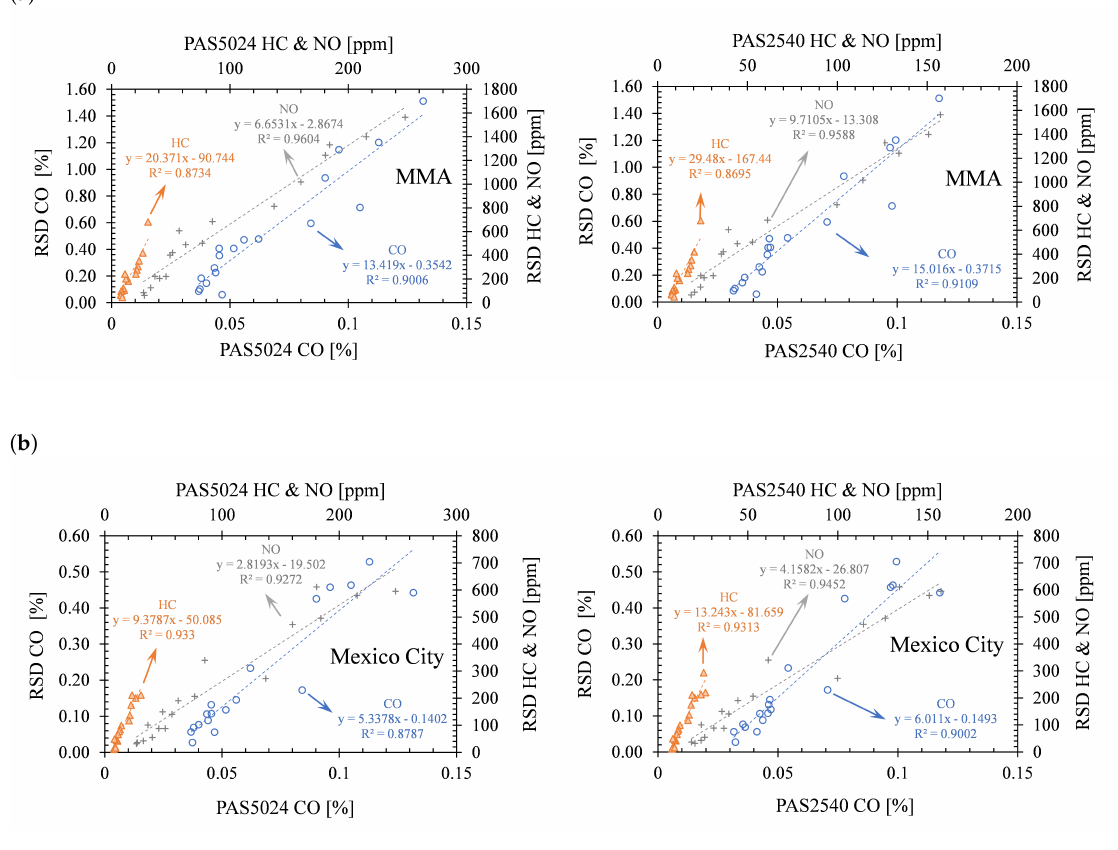
Figure 5. Correlation analysis between the CO, HC (hexane equivalent), and NO tailpipe mean model-year concentrations from RSD and the ASM I/M program (PAS5024 & PAS2540) for ( a ) MMA and ( b ) Mexico City. (Period 2000–2017).